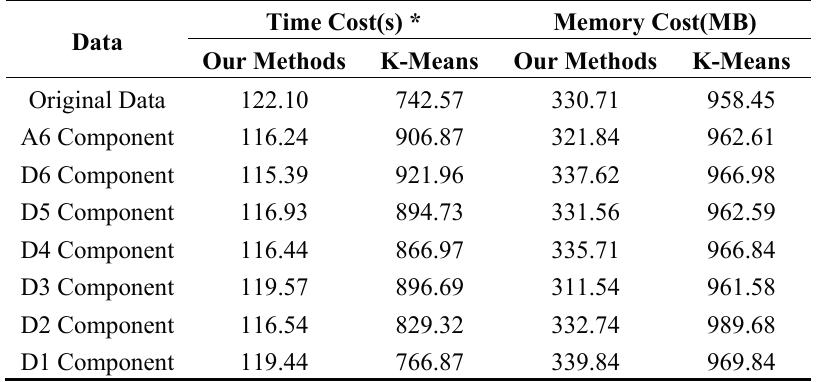
Table 3. Time and memory cost of the feature cluster